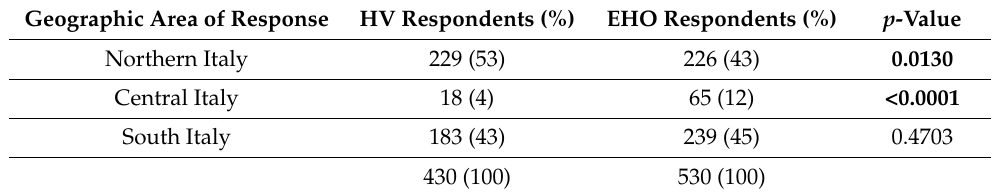
Table 1. Origin of answers provided by geographic area. Geographic Area of